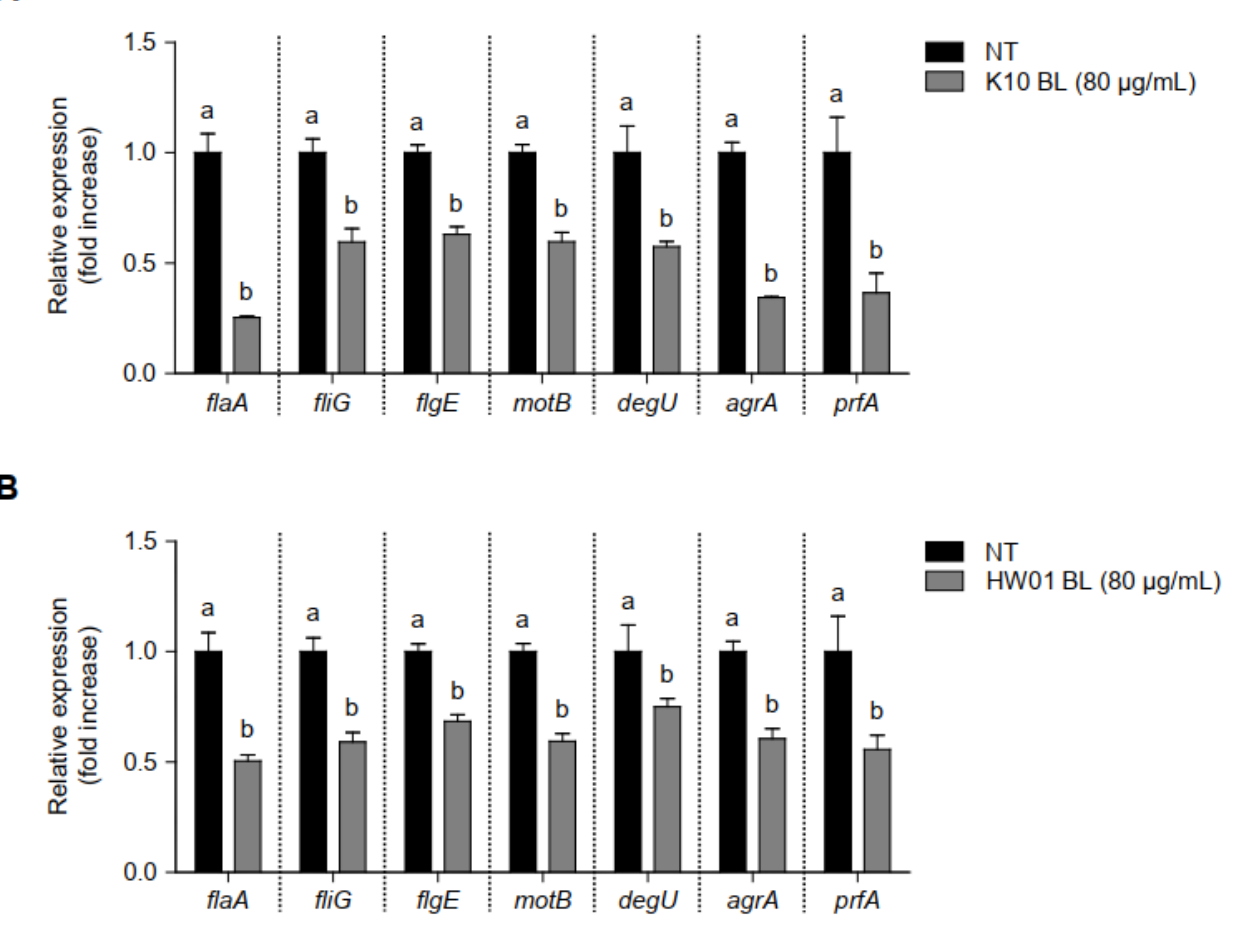
Figure 4. Regulation of gene transcription associated with L. monocytogenes biofilm formation in the presence or absence of P. acidilactici BLs. K10 BL ( A ) or HW01 BL ( B ) (80 μ g/mL) was preincubated for 3 h in a culture plate, after which L. monocytogenes was added and cultured at 37 °C for an additional 24 h. The expression levels of flaA , fliG , flgE , motB , degU , agrA , and prfA were measured using qRT-PCR. The results are represented as the means ± standard deviations from three independent experiments ( p < 0.05). Significant differences between treatment with K10 BL or HW01 BL are expressed with different letters (a and b).